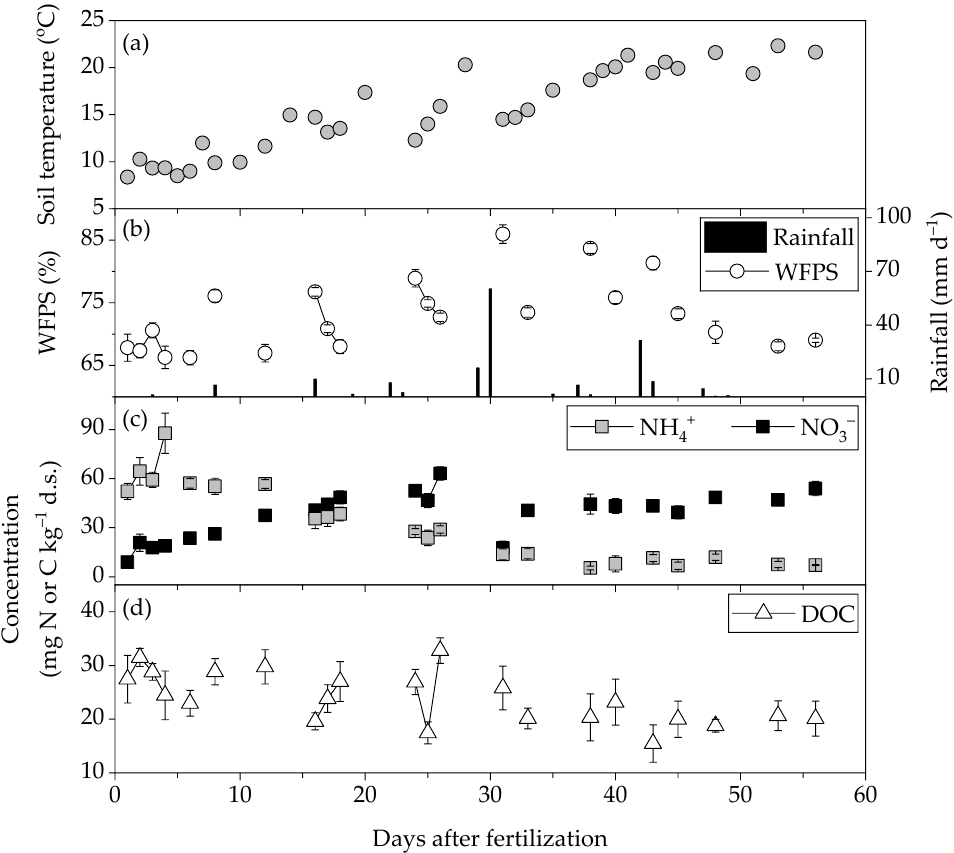
Figure 2. Temporal dynamics of ( a ) soil (10 cm) temperatures, ( b ) daily rainfall and soil (0–20 cm) moisture in water-filled pore space (WFPS), and concentrations of ( c ) soil (0–20 cm) ammonium (NH 4+ ) and nitrate (NO 3 − ), and ( d ) dissolved organic carbon (DOC) following the basal application of ammonium sulfate for maize. Each vertical bar indicates the standard error of three or six spatial replicates. The data were obtained following the basal ammonium fertilization for maize from 28 April to 22 June 2019.